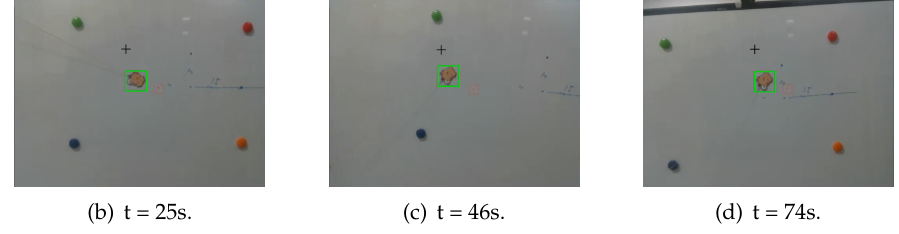
Figure 11. Camera’s FOV. Figure 12. Observation window of the